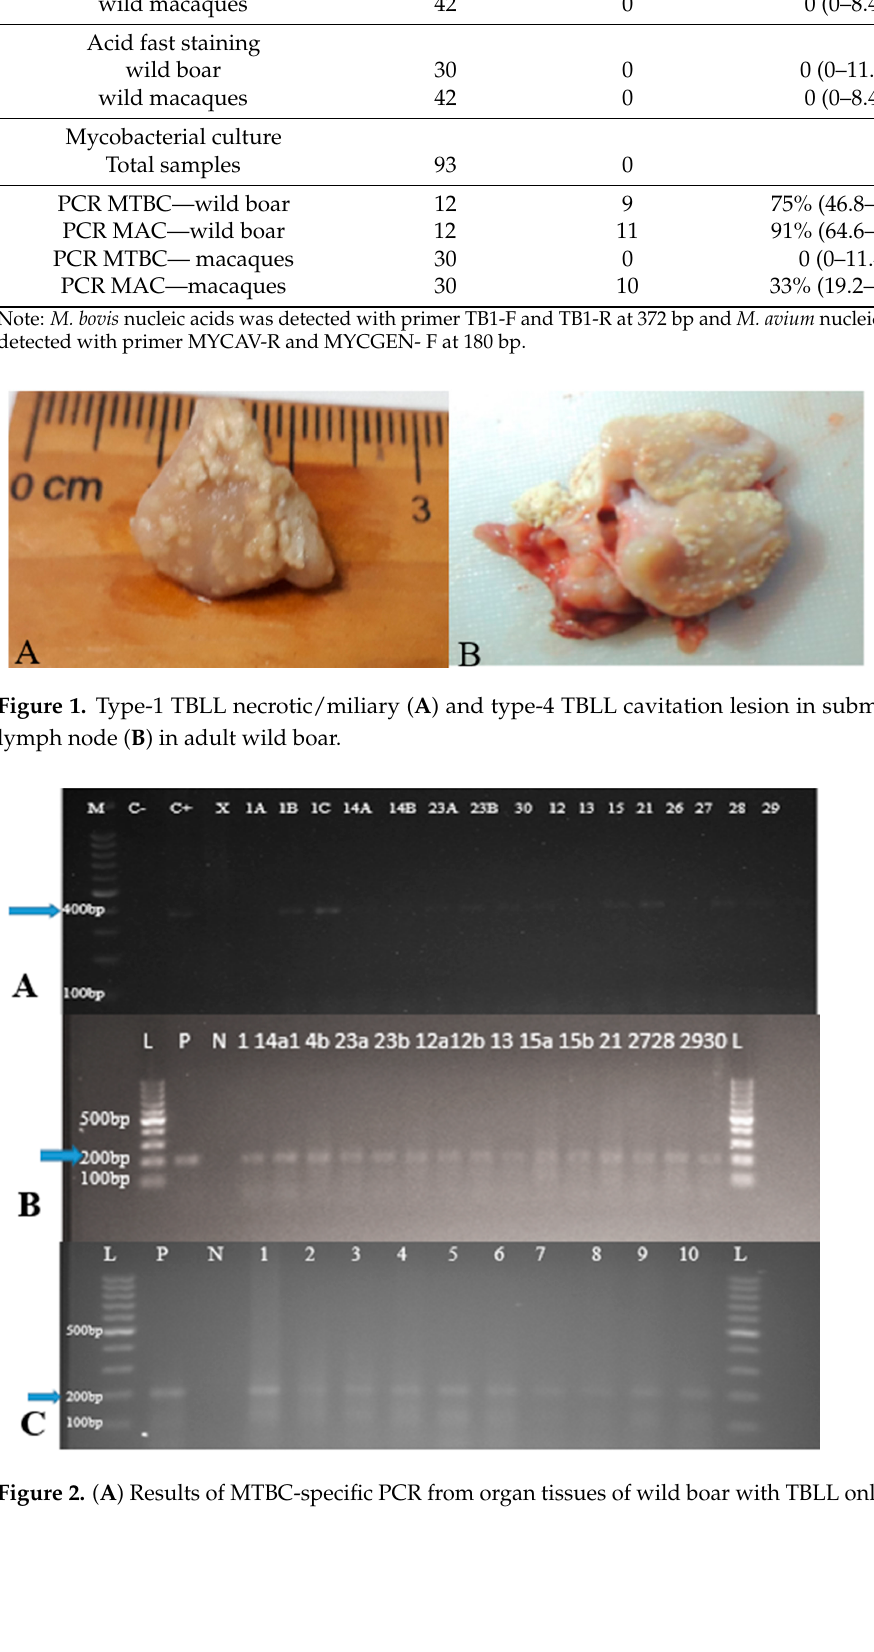
Figure 2. ( A ) Results of MTBC-specific PCR from organ tissues of wild boar with TBLL only.